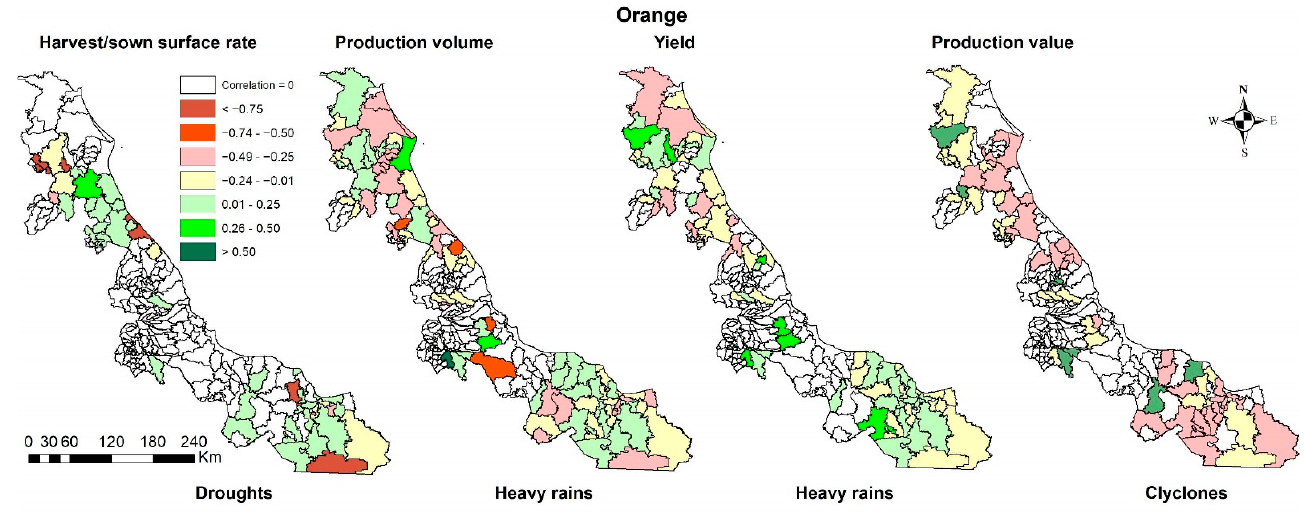
Figure 10. Orange crop data correlated with disaster declarations in the municipalities of the State of Veracruz from 2003 to 2020. Correlation = 0: sites with no correlation with phenomena. Source: projections based on data from the Mexican National Center to Prevent Disasters statistics [15] and the Mexican National Agrifood System [5].